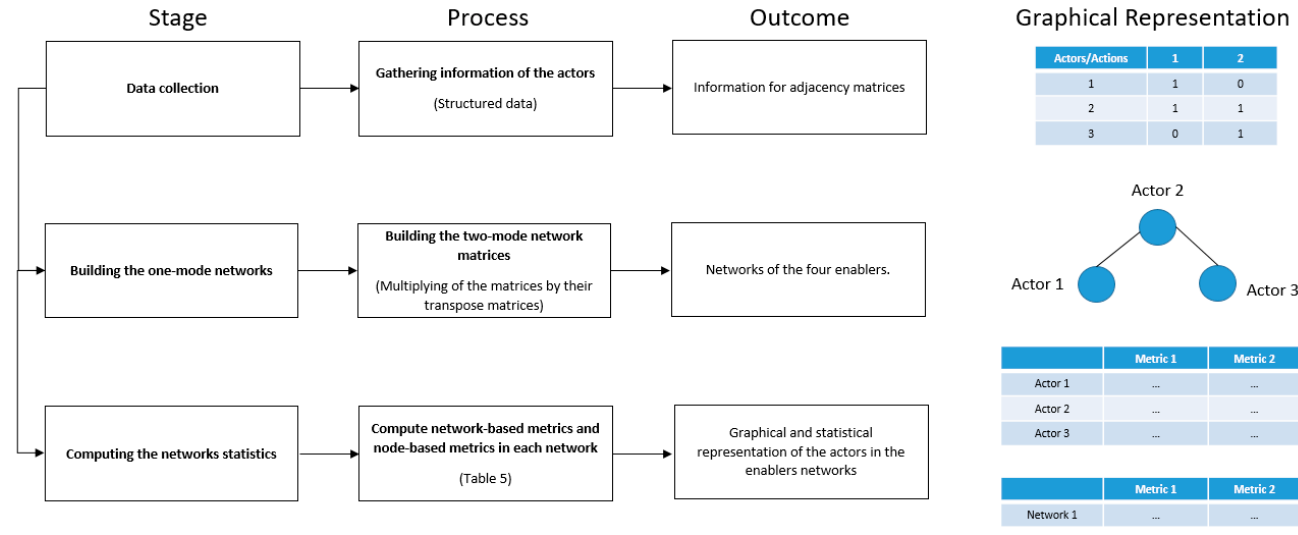
Figure 1. Methodology. Figure 1.